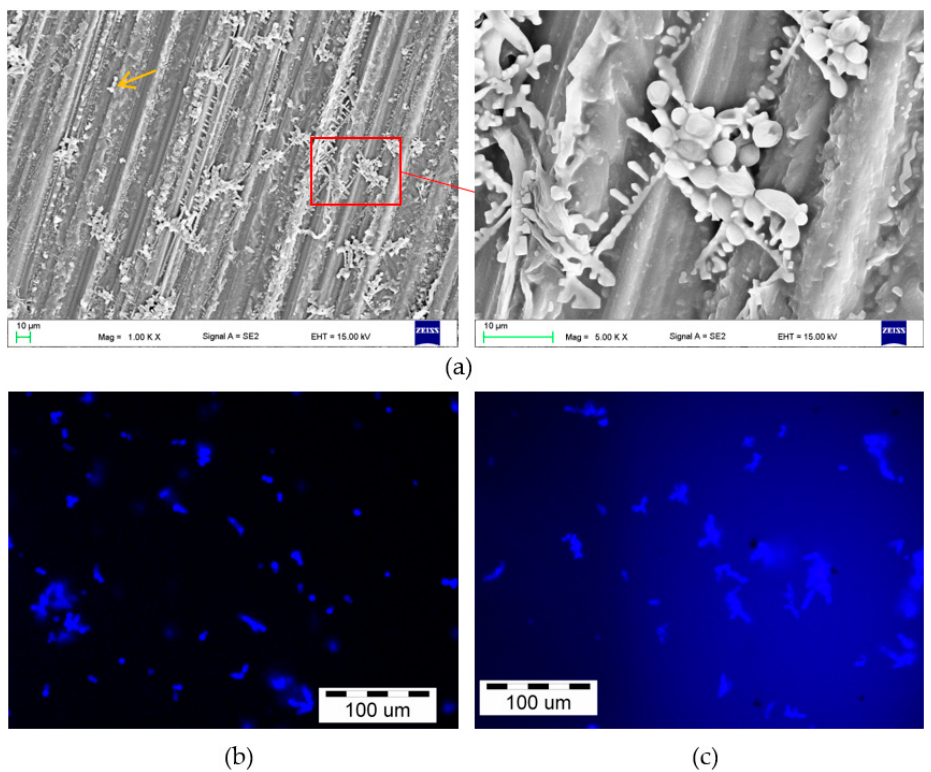
Figure 5. Representative microphotographs of the surface of the samples after 30 days of incubation in the C. albicans suspension obtained by SEM ( a ) and fluorescence microscopy ( b , c ), yellow arrow— exemplary colony inside the scratch.